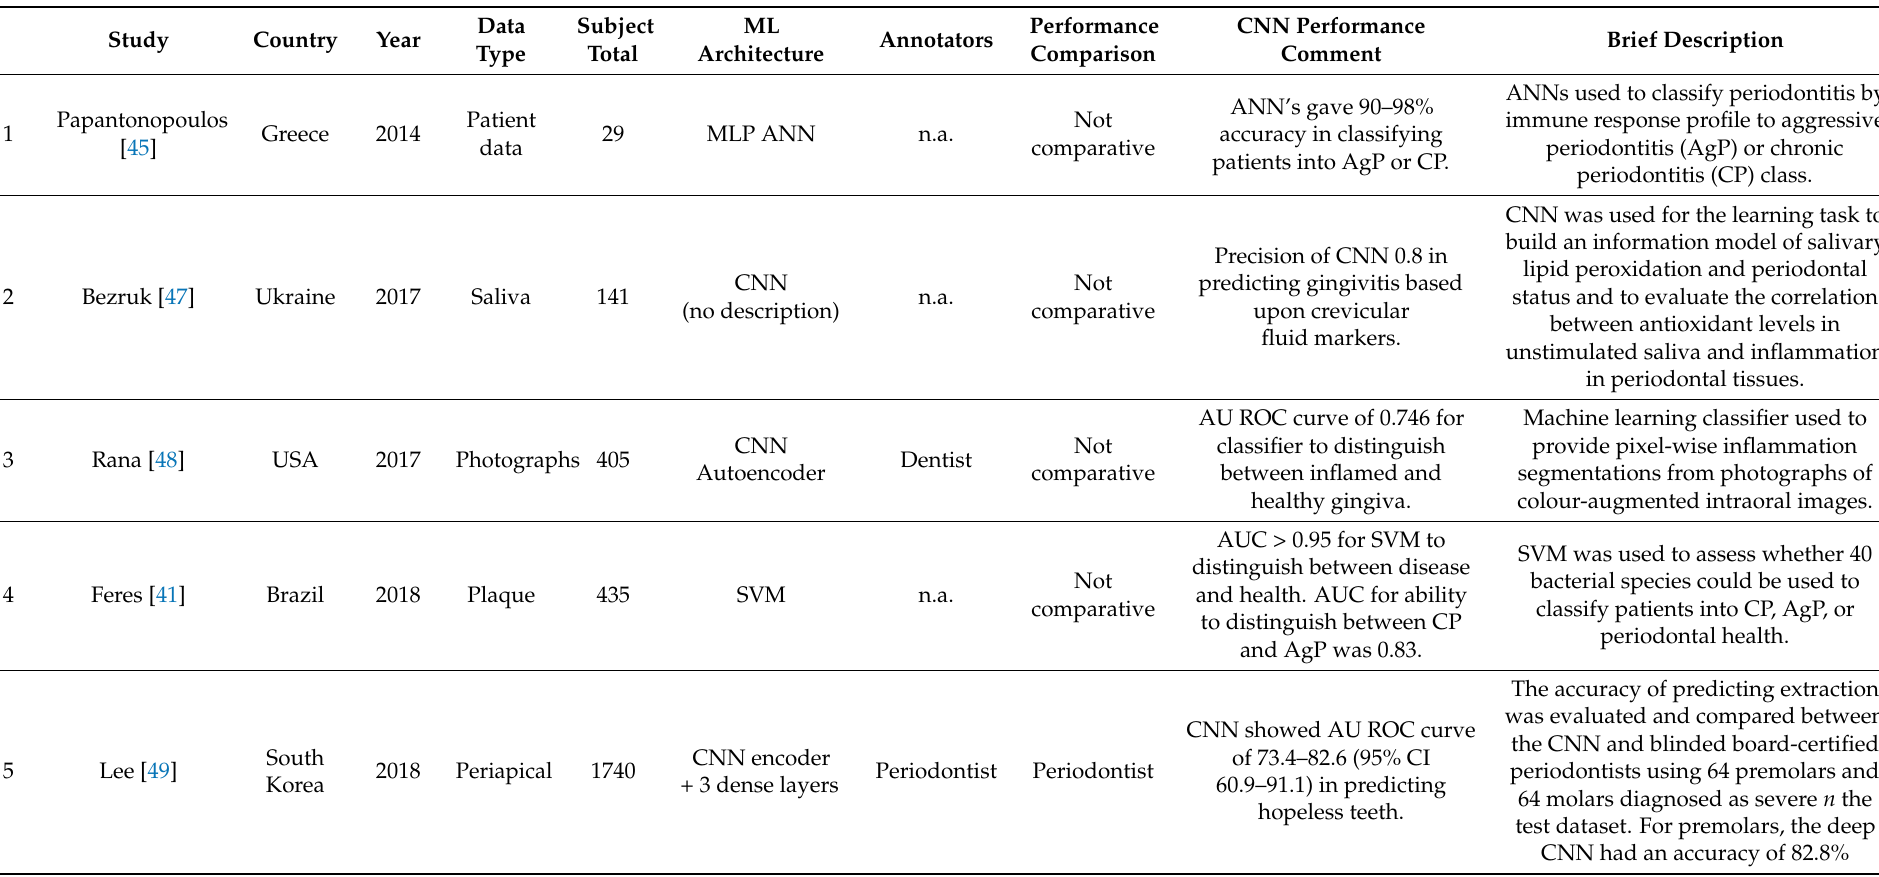
Table 1. Description of included